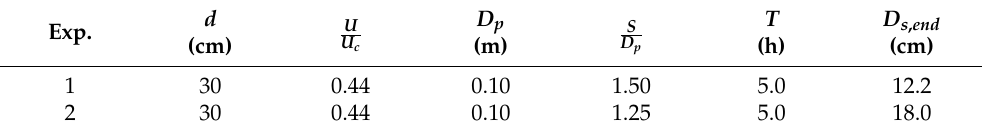
Table 1. Total experimental conditions and results.